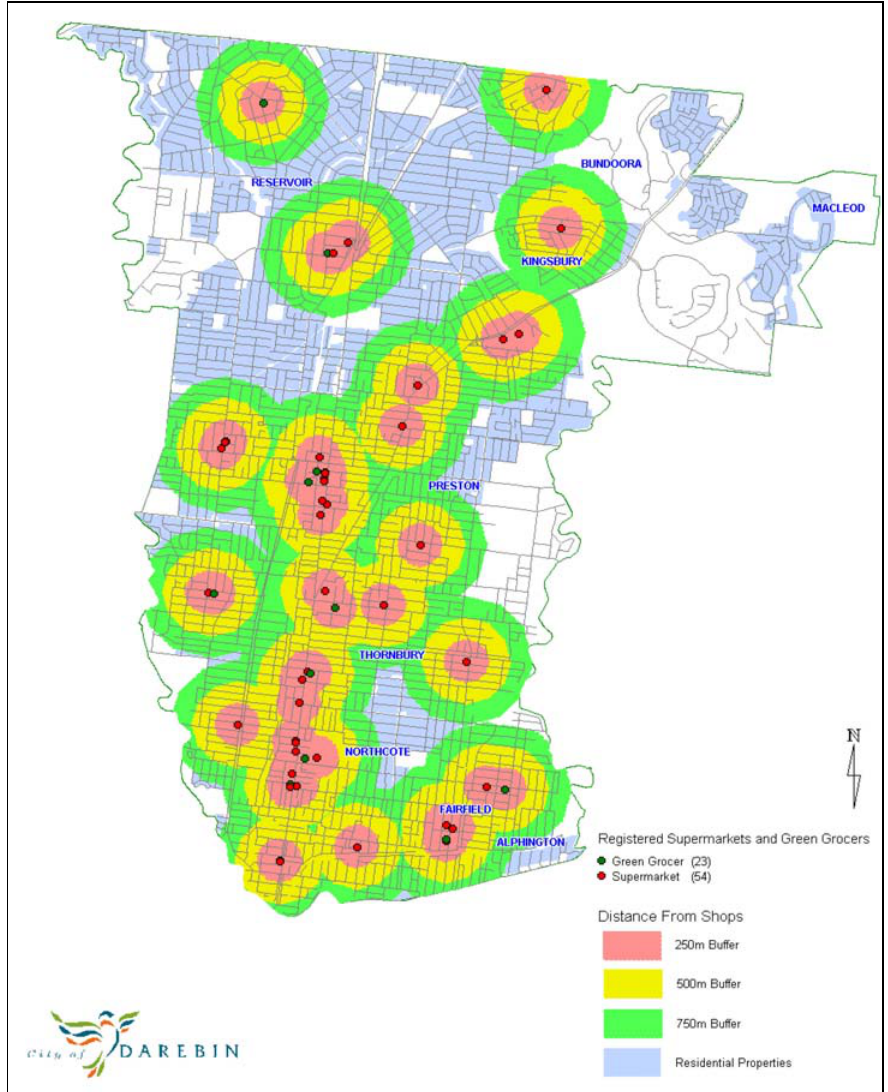
Figure 2. Visual Illustration of Food Desert Areas in the City of Darebin